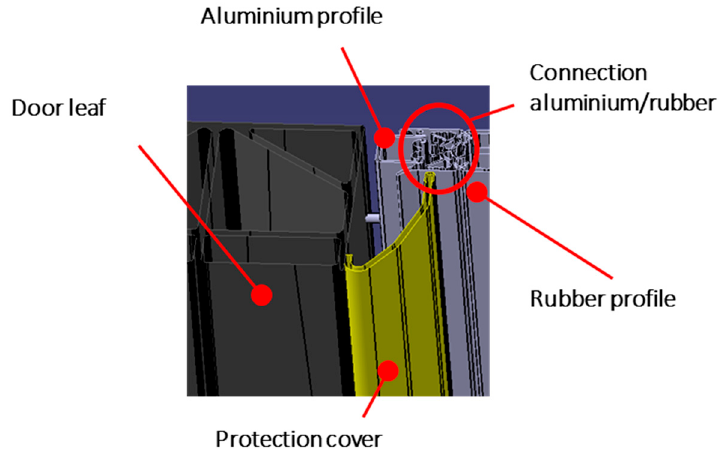
Figure 5. Installation of the lateral edge profile.